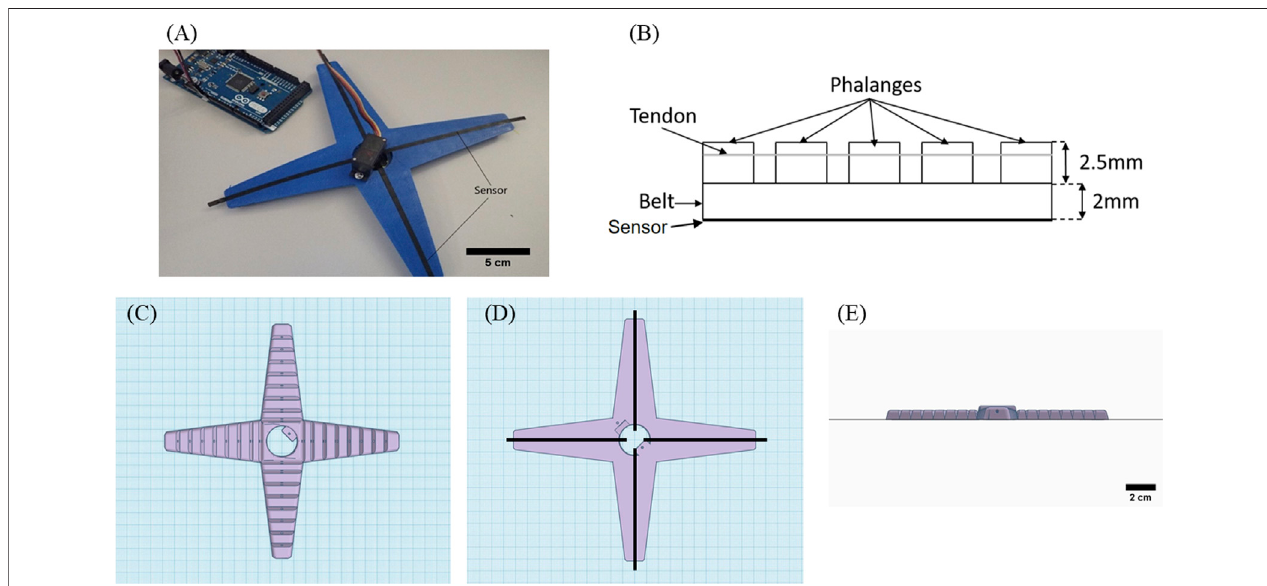
FIGURE1|(A) Softroboticgripperwithintegratedstrainsensorelementsproducedwithmulti-materialFDMprinting. (B) Sketchofatentacle,showingthebelt,the phalanges, and the wires (tendons) which are connected to the servomotor and the CAD design of the gripper. (C) Top view. (D) Bottom view. (E) Side view. This is an open-source design (Print-in-Place Robotic